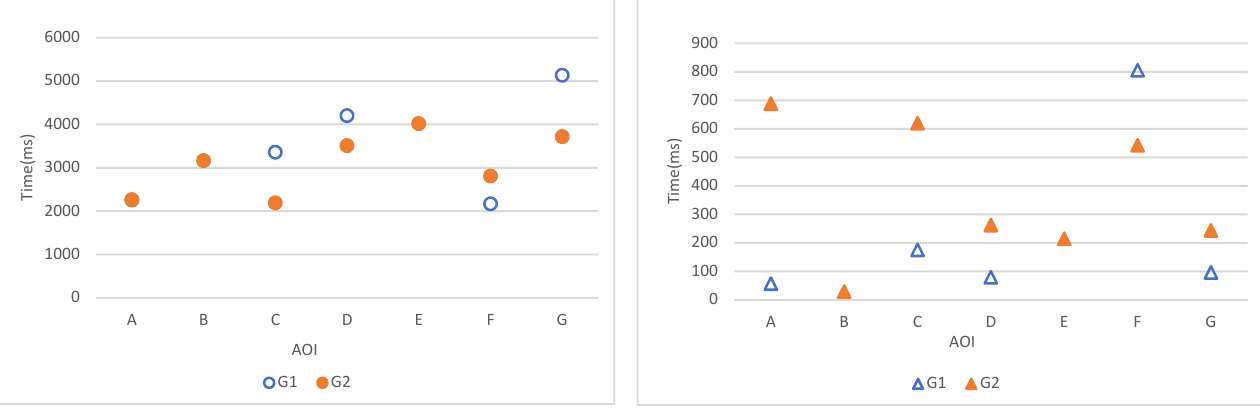
Figure 7. Average entry time and dwell time.